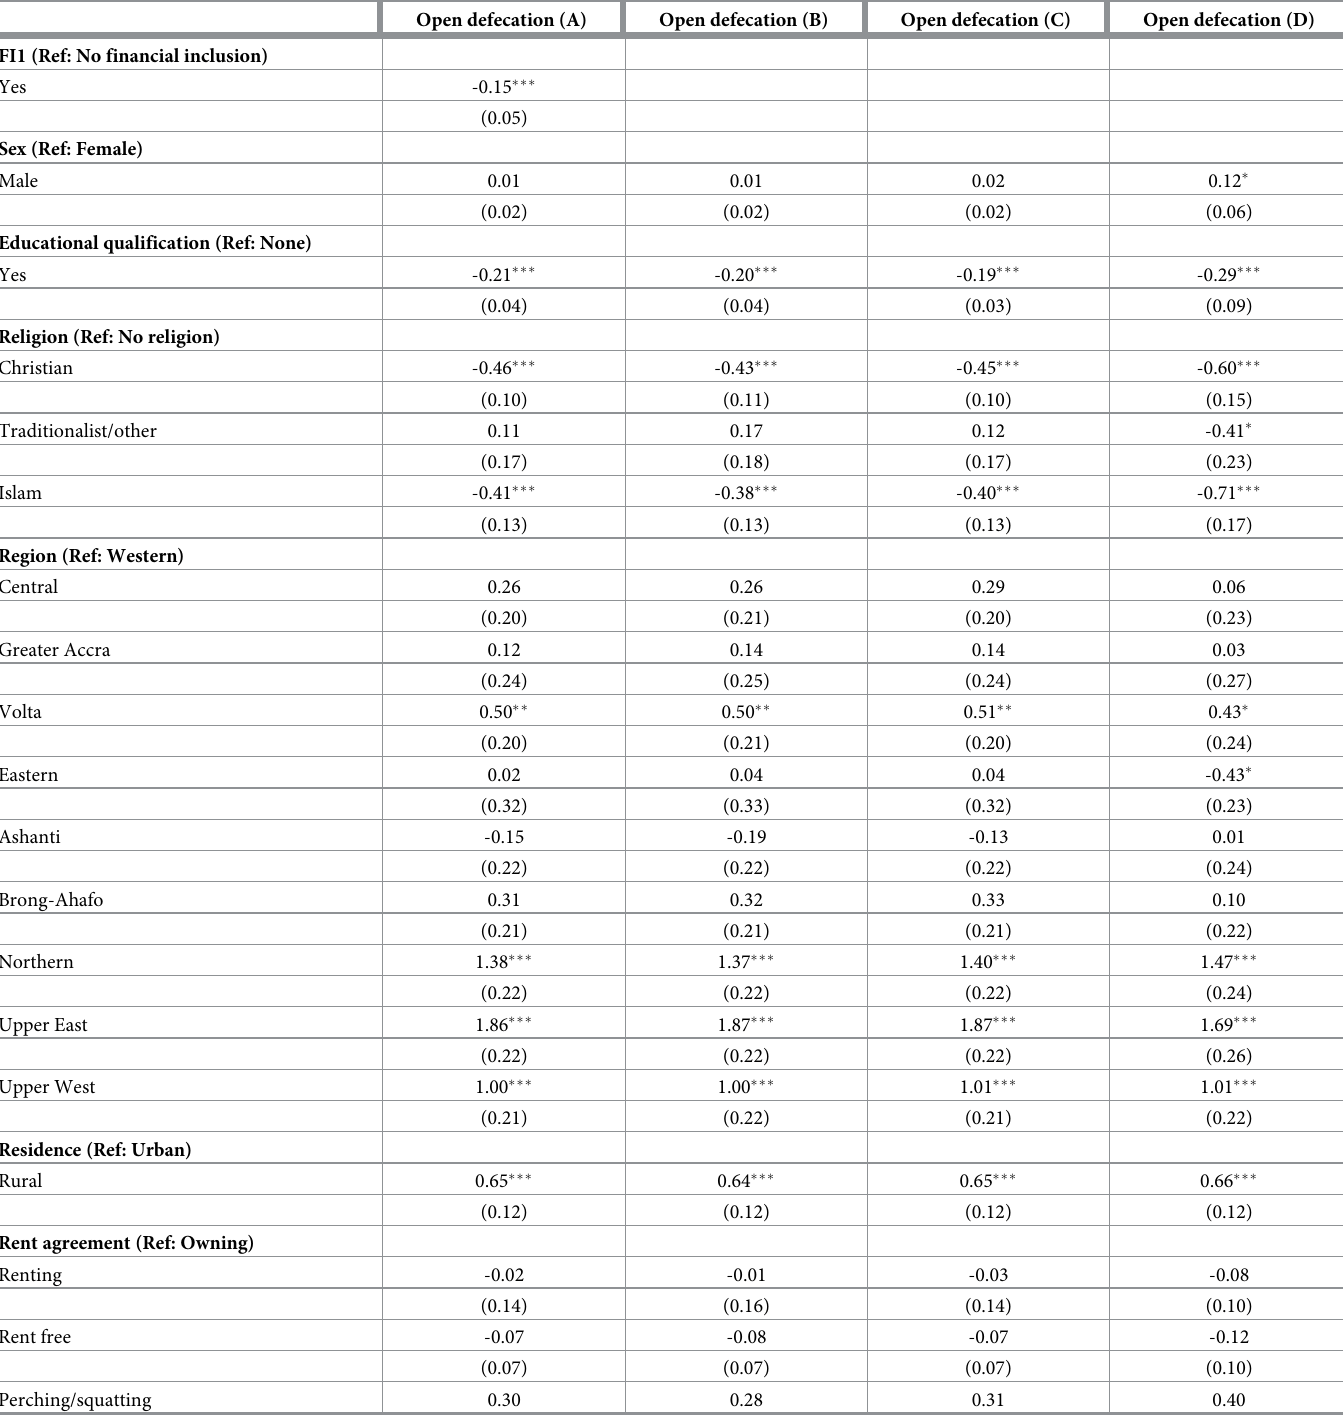
Table A1. Probit regressions: Effect of financial inclusion on open defecation (robustness checks). Open defecation (A) Open defecation (B) Open defecation